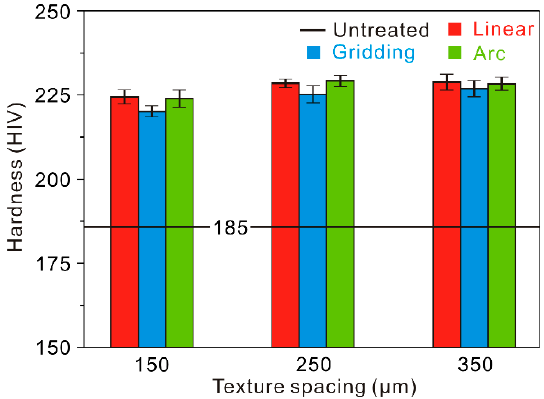
Figure 5. Micro ‐ hardness of the micro ‐ scale structure surfaces. Figure 5. Micro-hardness of the micro-scale structure